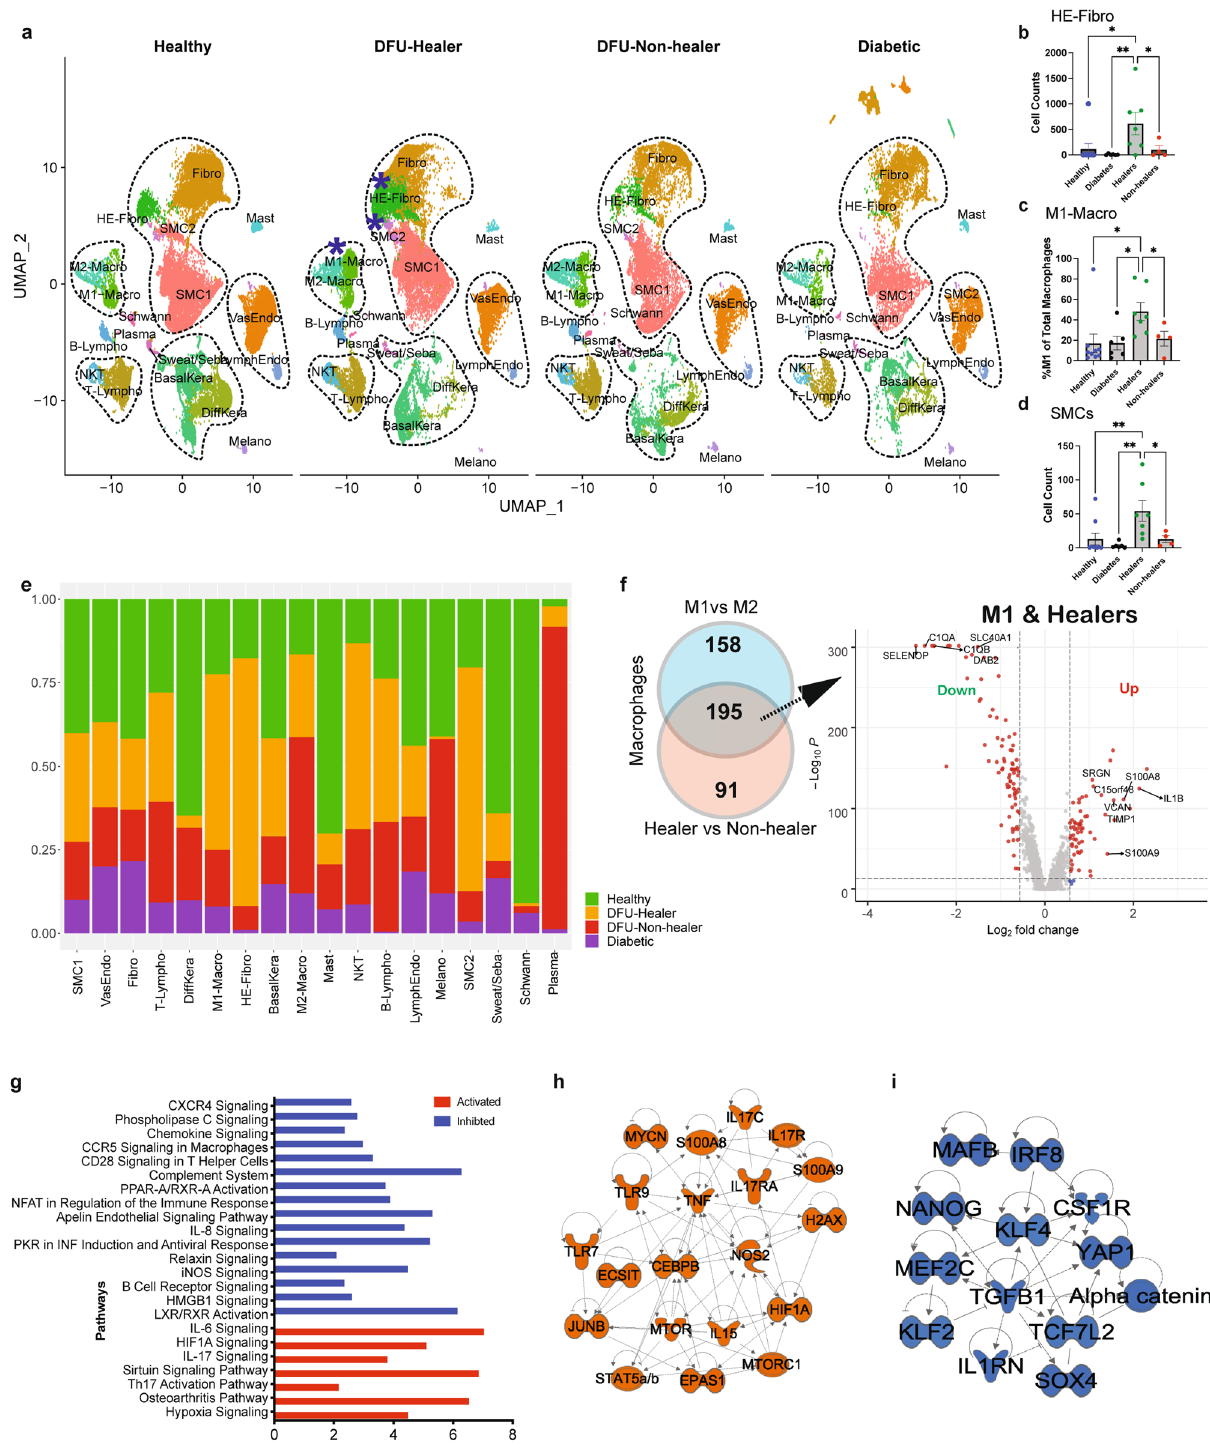
degradation of the ECM, stimulating leukocyte in fi ltration for resolution of in fl ammation and transition to the proliferative phase 42 . Cluster 4 exhibited overexpression of POSTN and ASPN (Fig. 5b) that are associated with ECM signaling, adhesion and migration. POSTN (Periostin) is a ligand for alpha-V/beta-3 and alpha-V/beta-5 integrins and supports adhesion and migration of epithelial cells 43 , and has been shown to play a regulatory role in fi broblast proliferation and in fl ammation 44,45 . ASPN (Asporin)